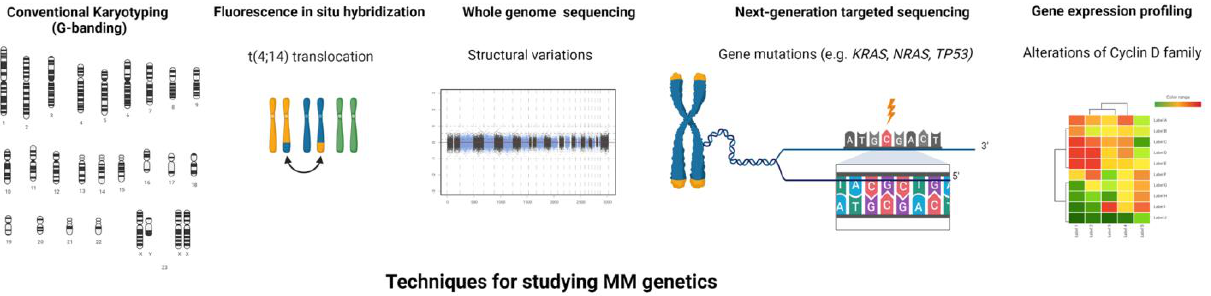
Figure 2. Techniques used for studying the genomics of multiple myeloma. The figure illustrates the various techniques used for the genomic dissection of multiple myeloma.